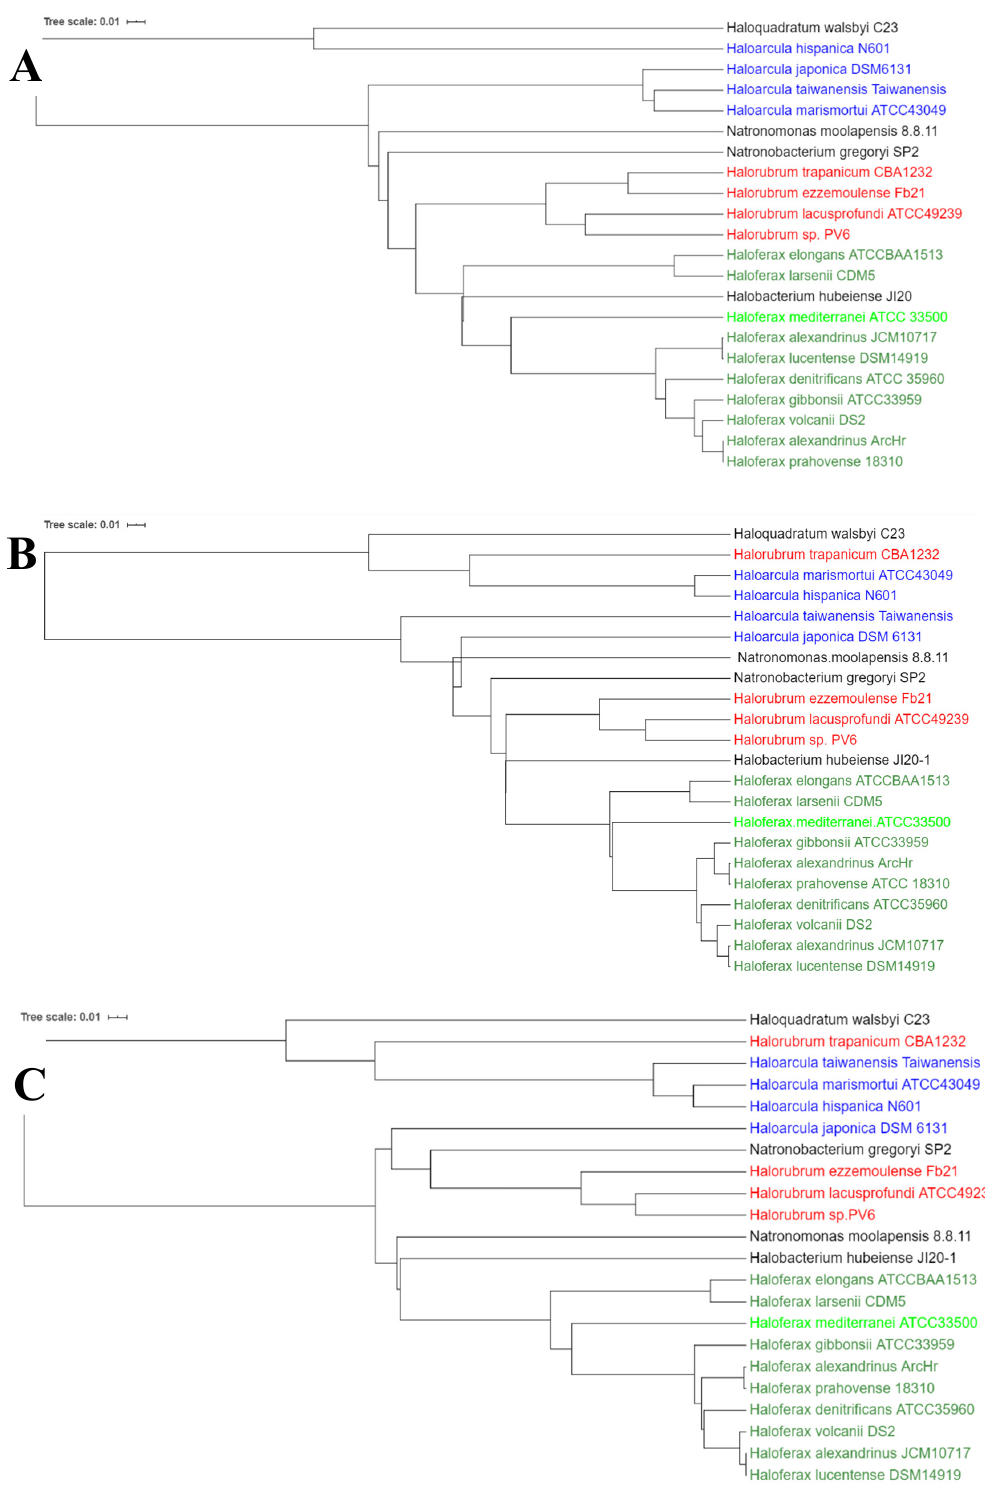
Figure 4. Unrooted phylogenetic tree of genes encoding the following enzymes: ( A ) Prenyltransferase; ( B ) phytoene desaturase; ( C ) putative bisanhydrobacterioruberin hydratase. Colors have been used to group species belonging to the same genus. Tree scale indicates the phylogenetic distance in branches. Trees were built with Clustal Omega (default settings) and annotation was done with iTol v4.